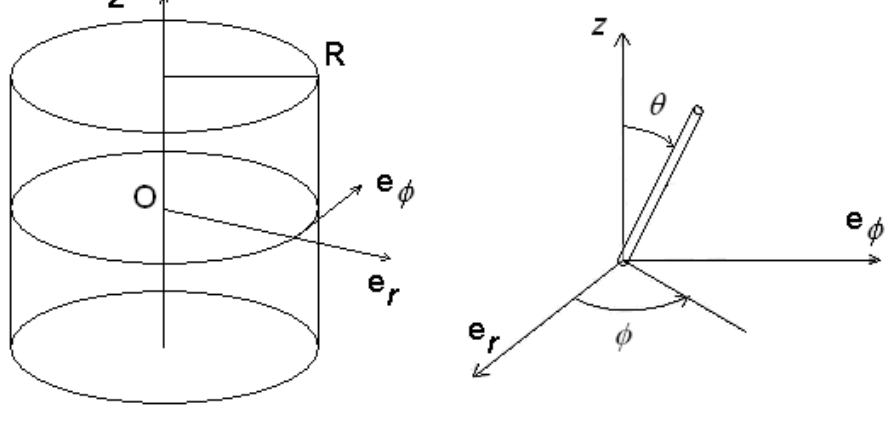
Figure 7 . Cylindrical cell and frame of references on the left and on the right the angles of director chosen for